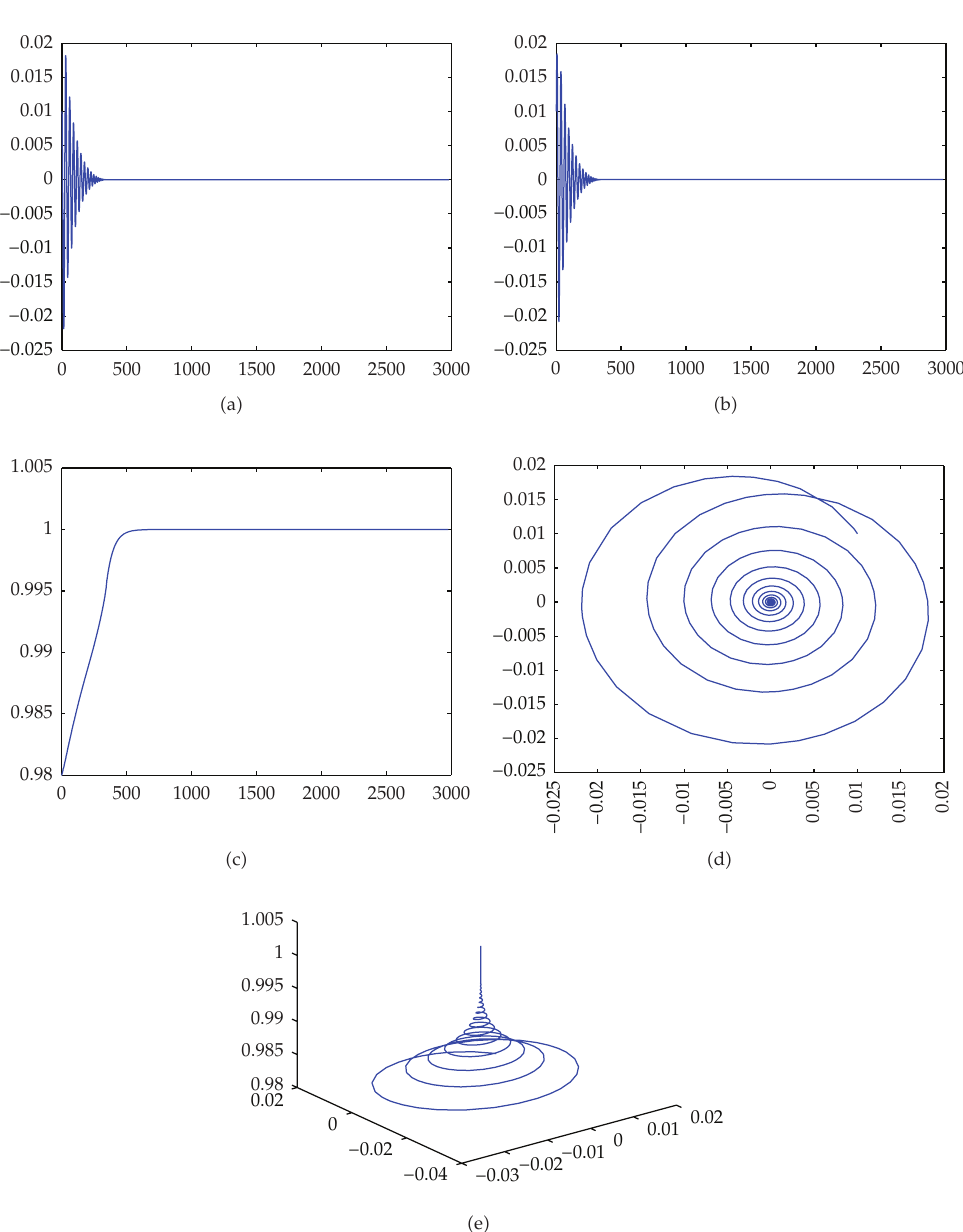
Figure 2: For system (cid:2) 1.4 (cid:3) with the data (cid:2) A (cid:3) , the equilibrium E (cid:2) 0 , 0 , 1 (cid:3) is asymptotically stable when τ ∈ (cid:2) τ − (cid:3) , where τ (cid:7) 0 . 6 and the initial value is taken as (cid:2) 0 . 01 , 0 . 01 , 0 . 98 (cid:3) . ,τ (cid:8) 0 0